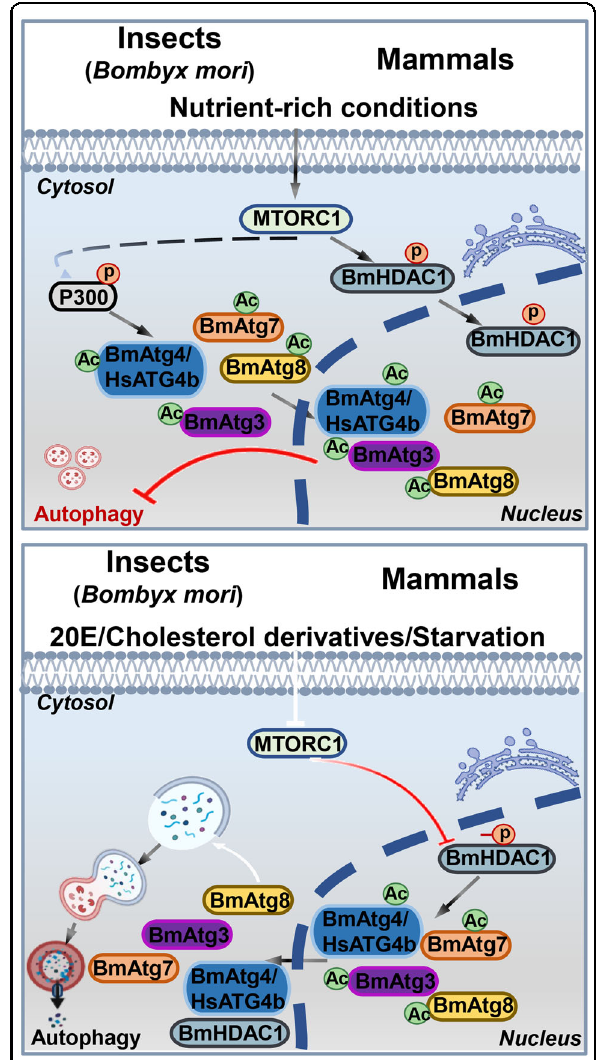
Fig. 7 A model for the regulation of autophagy mediated by acetyltransferase/deacetylase in B. mori and mammals. Components of the LC3/Atg8 – PE ubiquitin-like system are acetylated by acetyltransferase, such as BmP300, and then translocated from the cytoplasm to the nucleus under nutrient-rich conditions. Simultaneously, high MTOR activity phosphorylates the histone deacetylases BmHDAC1/ HsHDAC1, resulting in their nuclear localization. 20E, cholesterol derivatives, and starvation, which inhibit MTOR signaling, leads to the dephosphorylation of BmHDAC1/HsHDAC1, and facilitates the deacetylation of Atg proteins from LC3/Atg8 – PE ubiquitin-like system, subsequently promoting their nucleo-cytoplasmic translocation and autophagy occurrence in both B. mori and